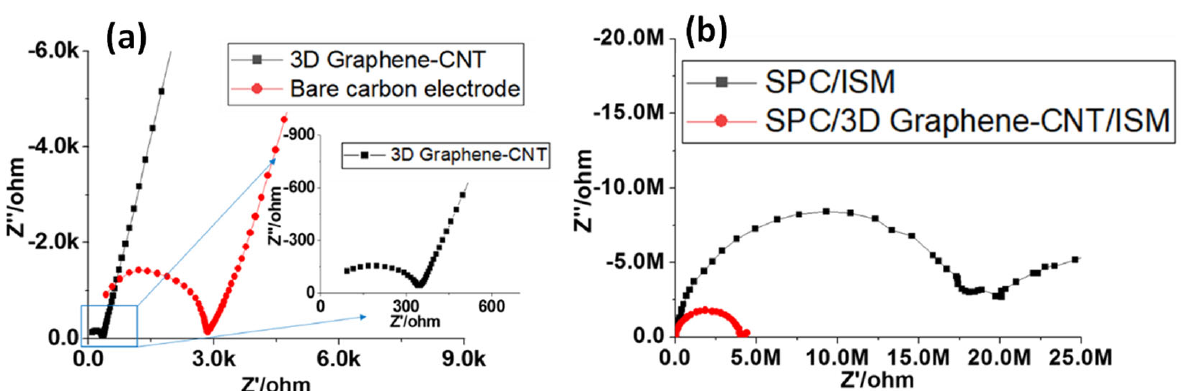
Figure 5. ( a ) EIS results for the bare carbon electrode and 3D Graphene–CNT modified electrode in 0.1 M NH 4 Cl solution, respectively; ( b ) EIS results for the screen-printed carbon (SPC) electrode modified by Graphene–CNT and an NH 4+ ISM coating and that with only an NH 4+ ISM, respectively, in 0.1 M NH 4 Cl solution. ( ∆ E ac : 100 mV; frequency range: 0.1 Hz–1 M Hz). In Figure 5a, the EIS results for the 3D Graphene–CNT modified electrode showed a reduced diameter of the semicircle compared to that of the bare carbon electrode,